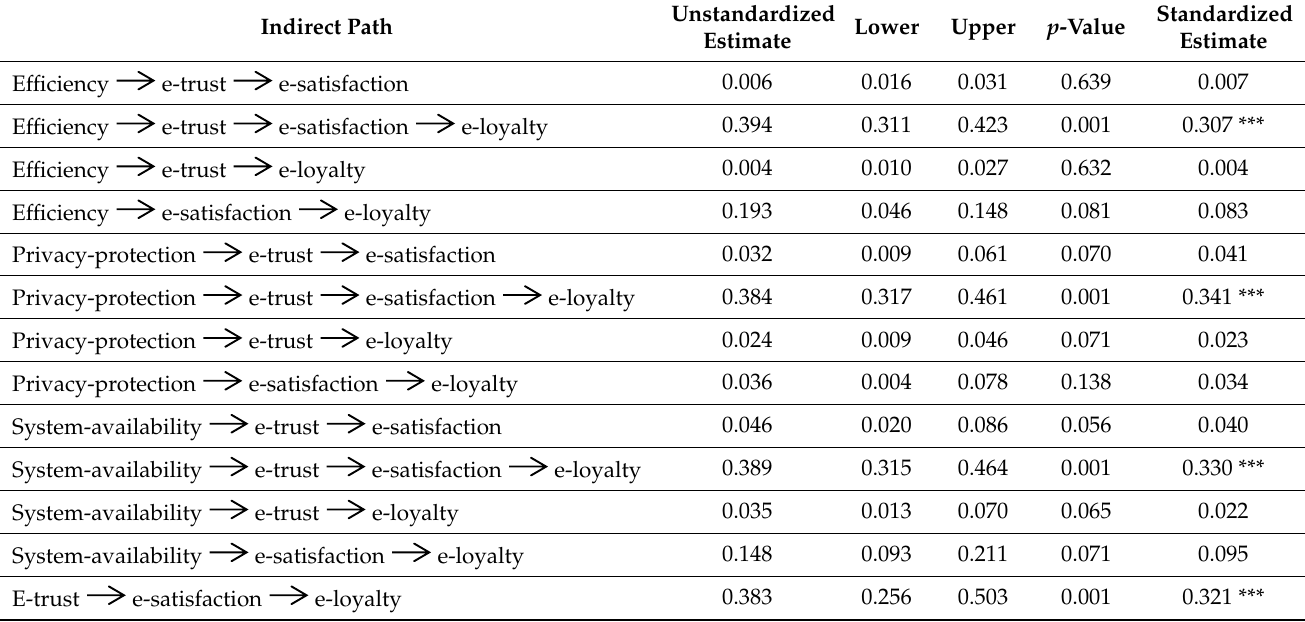
Table 4. Specific indirect effects from AMOS calculations.